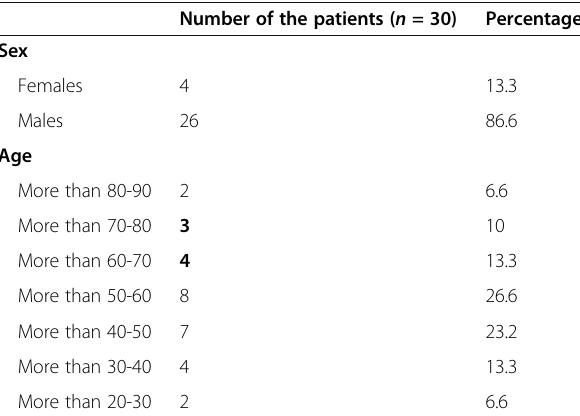
Table 1 Distribution of the studied patients according to demographic